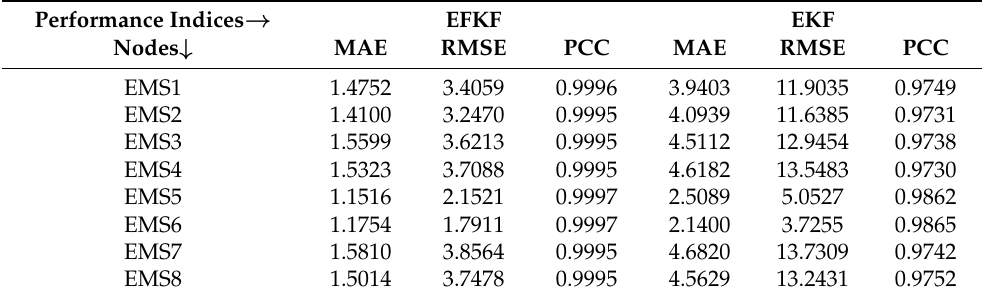
Table 2. Performance statistics of EFKF and EKF in dataset of PM2.5 during bushfire event.